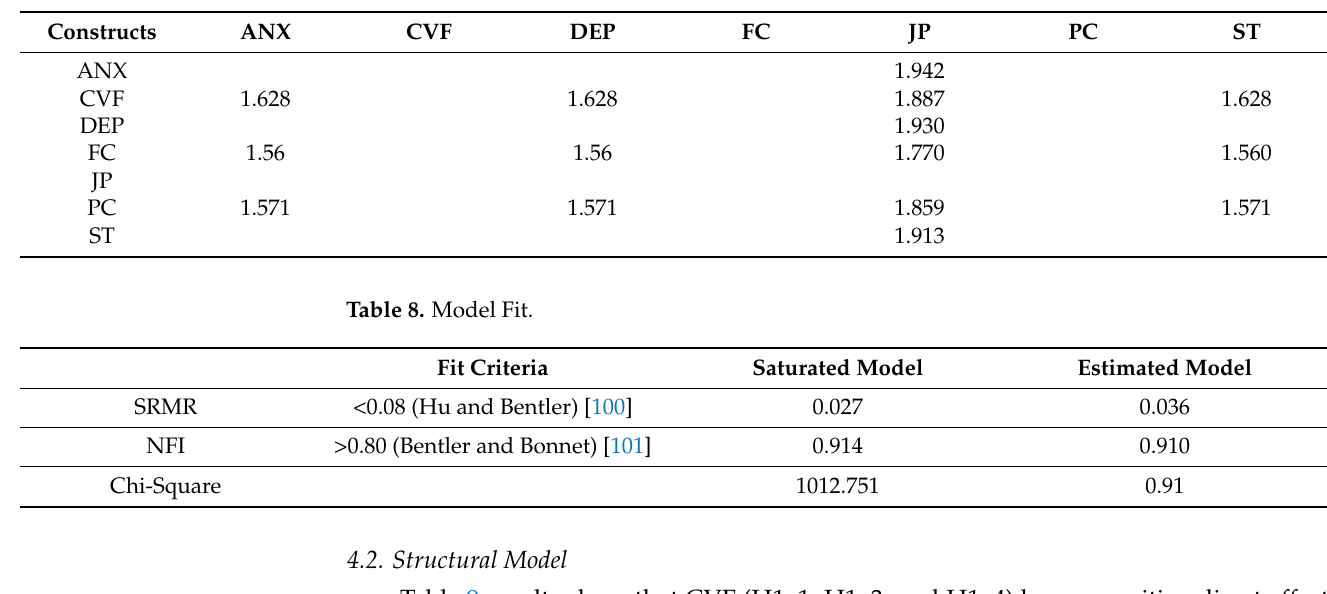
Table 7. Variance Influence Factor.